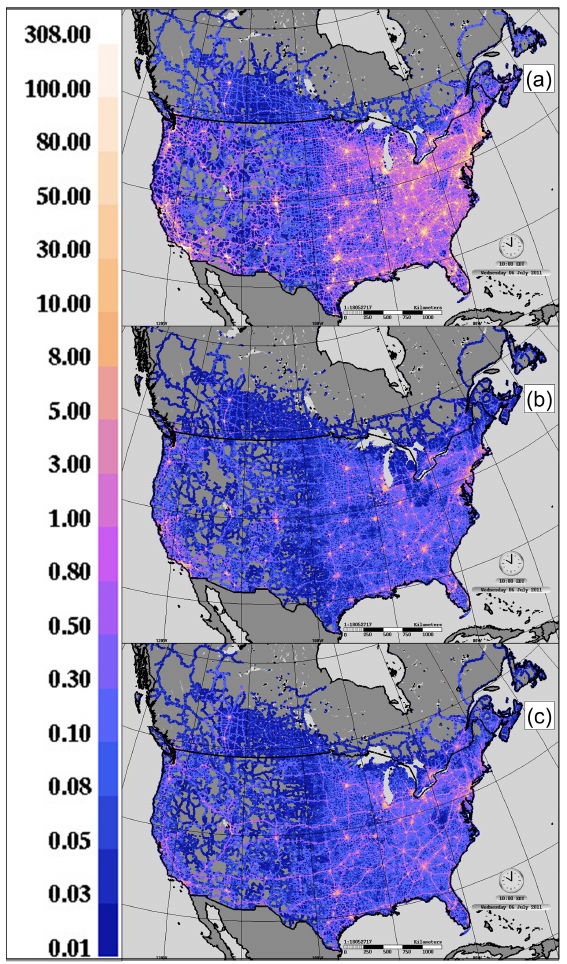
Figure 3. Vehicle kilometer traveled per 10km grid cell (kms − 1 ) for (a) cars, (b) mid-size vehicles, and (c) trucks, July 2015.